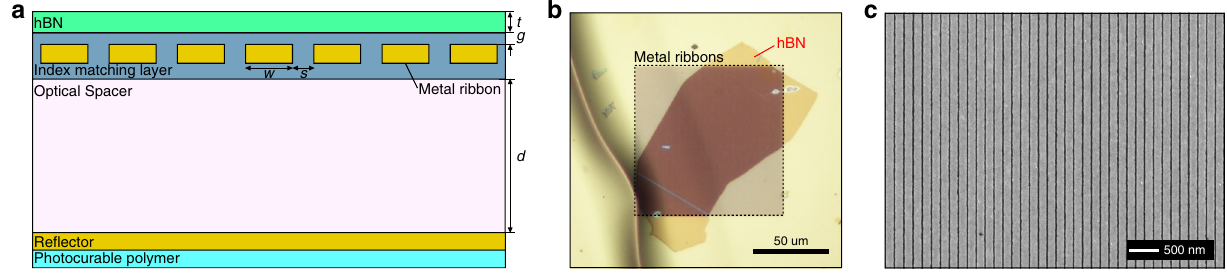
Fig. 2 Device architecture. a Schematic illustration of the image polariton resonator. w , s , g , and t denote the width of a metal ribbon, the spacing between neighboring metal ribbons, the gap size between the hBN and the conducting plate, and the thickness of the hBN. d denotes the thickness of an optical spacer, which is determined by the quarter wavelength condition to enhance the coupling ef fi ciency of far- fi eld light into image polaritons. b Optical microscope image of a h 10 BN fl ake transferred on the template-stripped substrate. c Scanning electron microscopy image of metal ribbons with p = 150 nm.